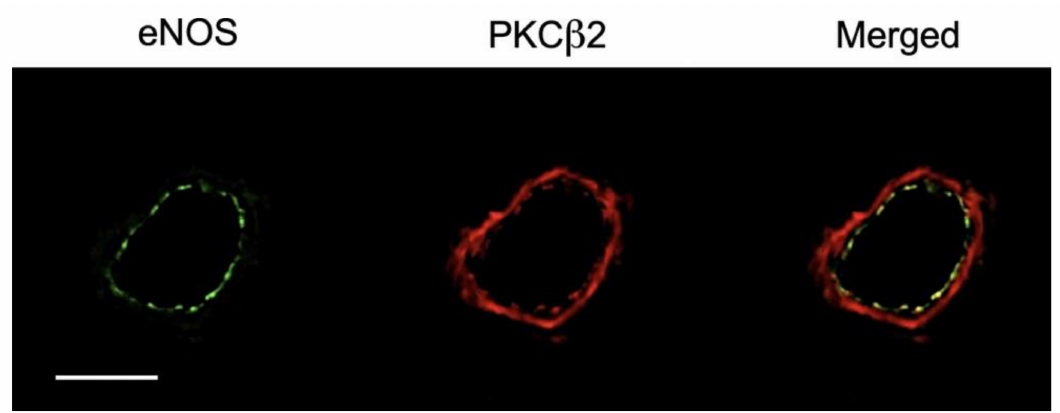
Figure 5. Immunohistochemical detection of endothelial NOS (eNOS) and PKC β 2 in porcine coronary arterioles. The expression of PKC β 2 (red) was found in smooth muscle and endothelial cells and co-localized with eNOS (green) in the endothelial layer (three independent experiments). Scale bar represents 50 µ